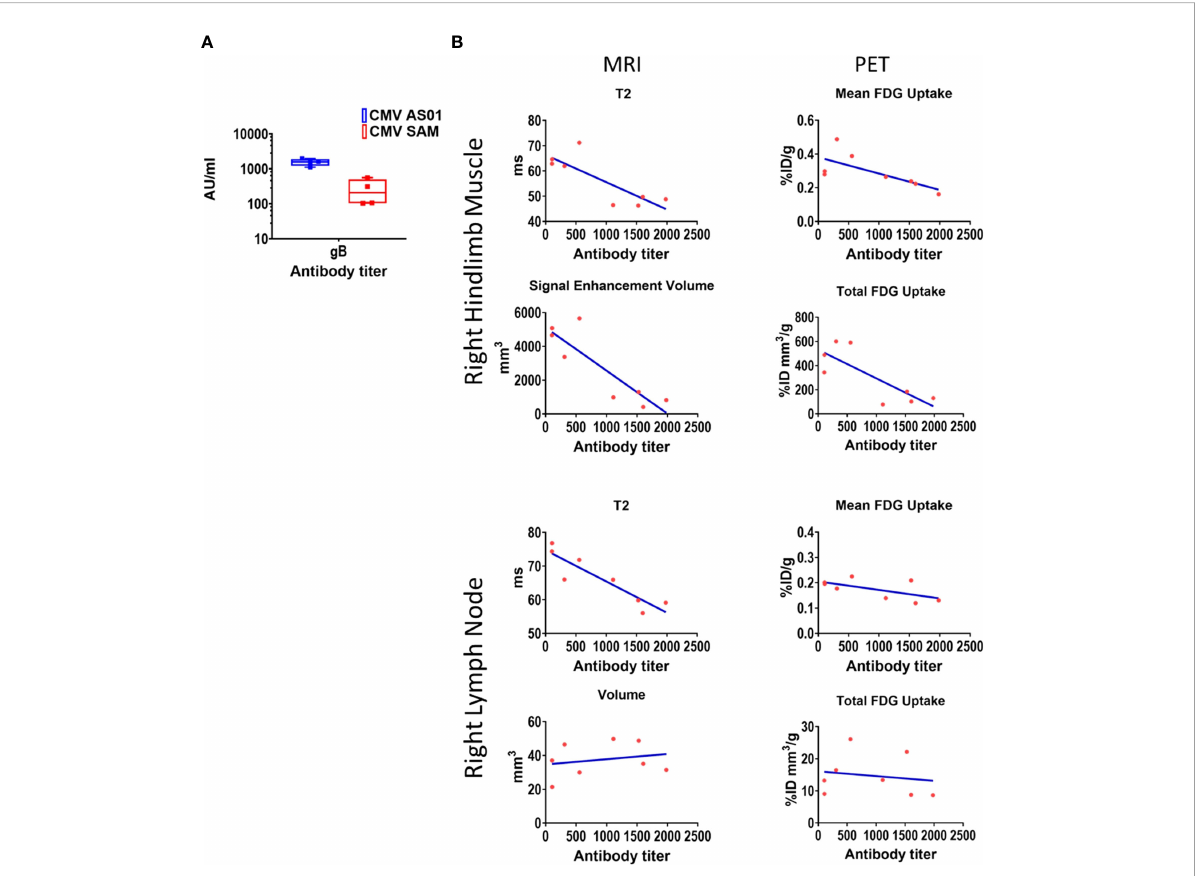
FIGURE 8 CMV antibody titers and correlation to MRI and PET imaging endpoints. Antibody titers for CMV gB (CMV AS01 and CMV SAM) were measured 72 hr post Prime-Boost vaccination (A) . Pearson correlations between CMV gB antibody titers and right hindlimb and draining lymph node MRI and 18 FDG PET endpoints (B) . CMV gB antibody data are shown in box and whisker plot format. AU (arbitrary